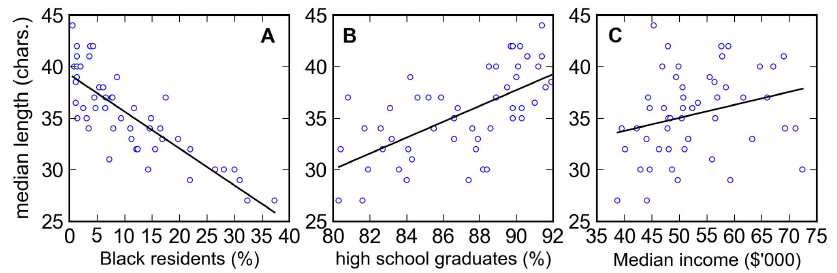
Figure 7. Median utterance length against demographic and socioeconomic variables. The bootstrapped median utterance length plotted against A. 2011 resident Black population in percent ( r 2 ~ 0 : 685 ), B. persons 25 years and over who are high school graduates or higher from 2007 to 2011, in percent ( r 2 ~ 0 : 397 ) and C. Median household income from 2007 to 2011 in thousands of dollars ( r 2 ~ 0 : 068 ). The linear regression line is also shown in each